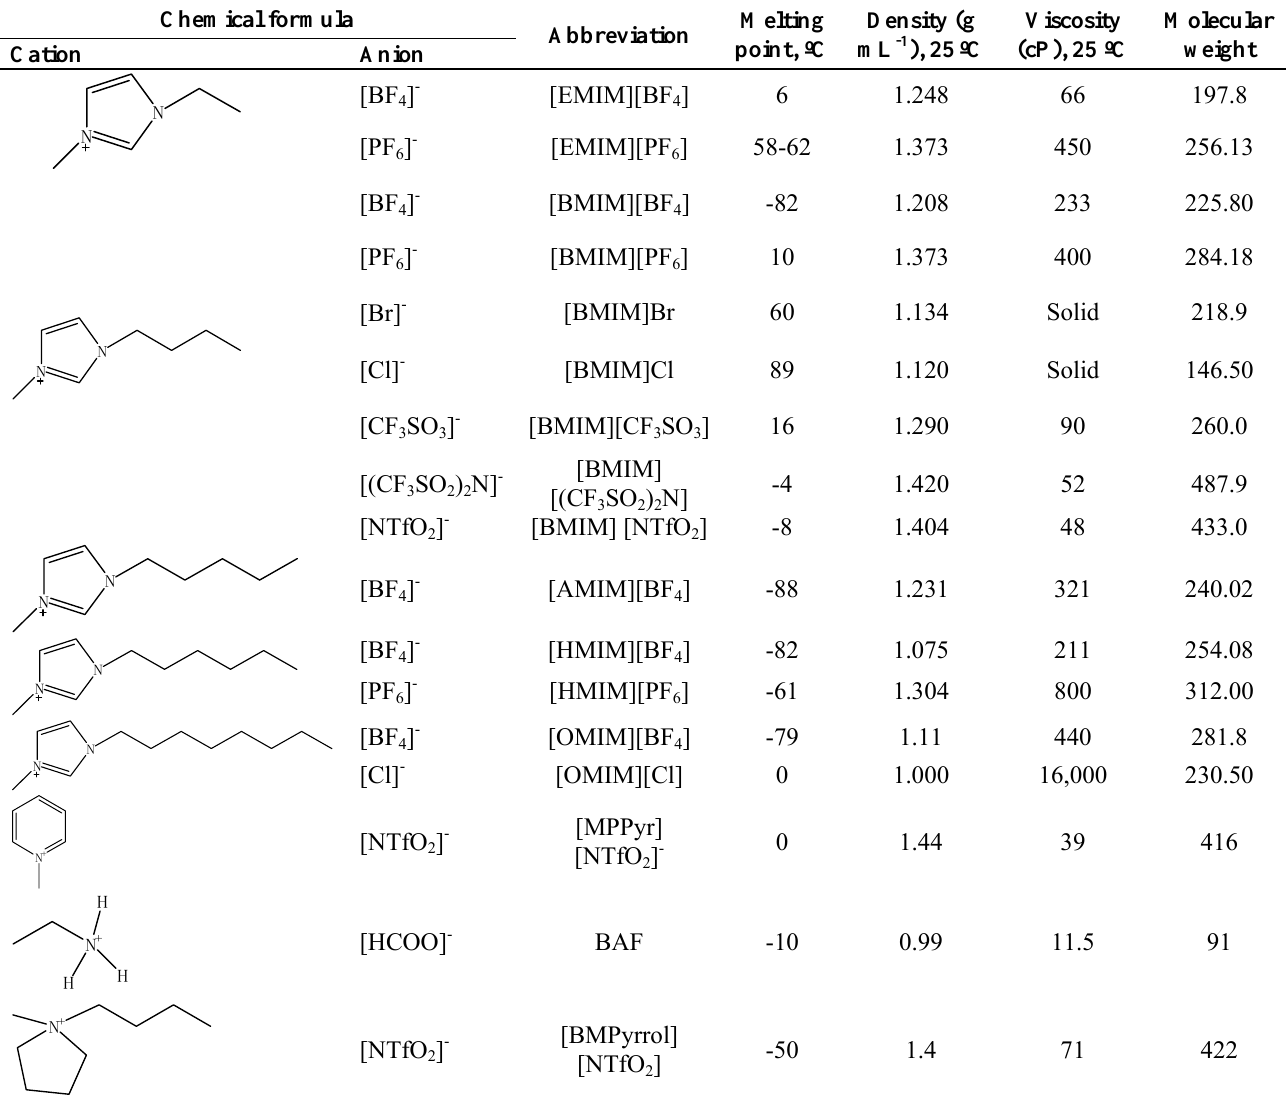
Table 1. Physical properties of ionic liquids in separation